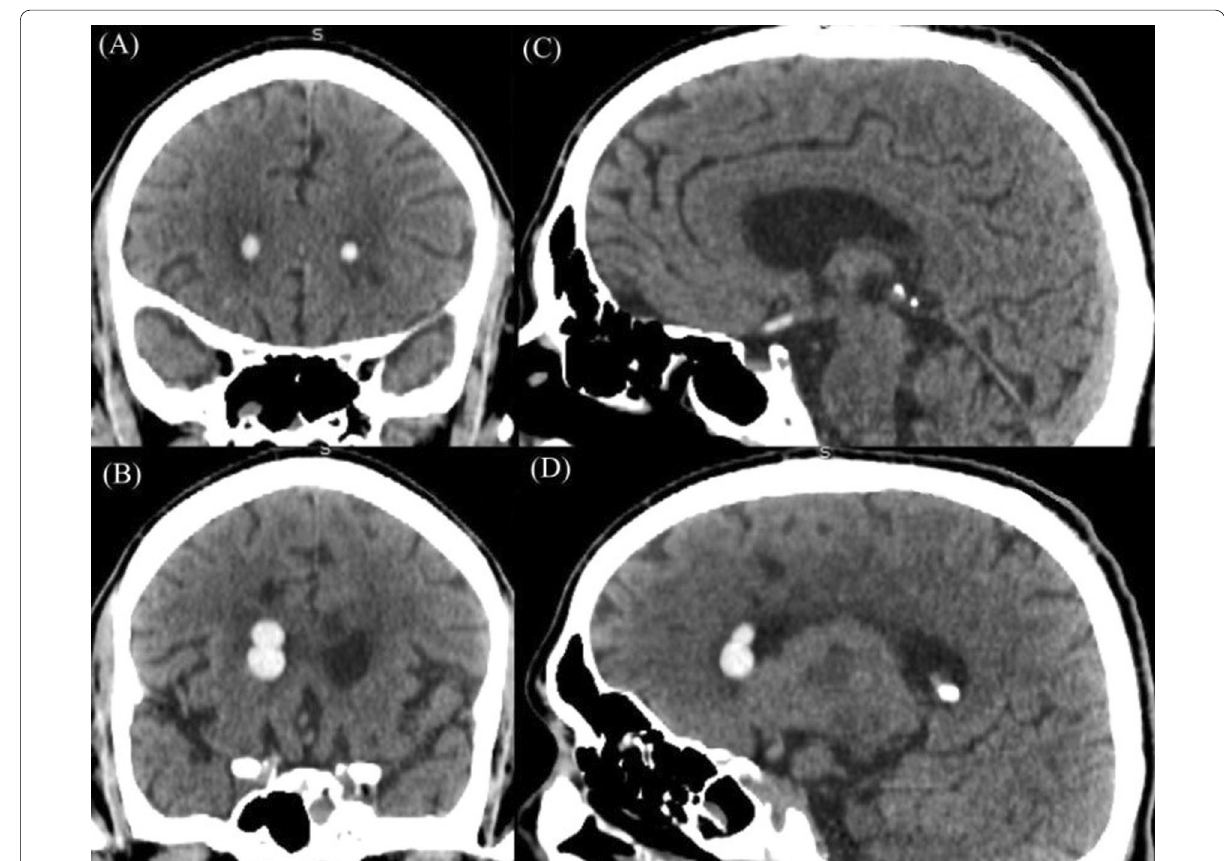
Fig. 2 Coronal ( A , B ) and sagittal ( C , D ) images NCCT of the head show multiple hyperdense globules in a non-dependent location ( A , B , D ). Two globules in close contact are noted on the right side ( B , D ). C Linear hyperdensity noted in the region of the right side of the optic chiasma. Also, note the chronic lacunar infarcts in the corpus callosum ( B ) and right gangliocapsular region ( D )